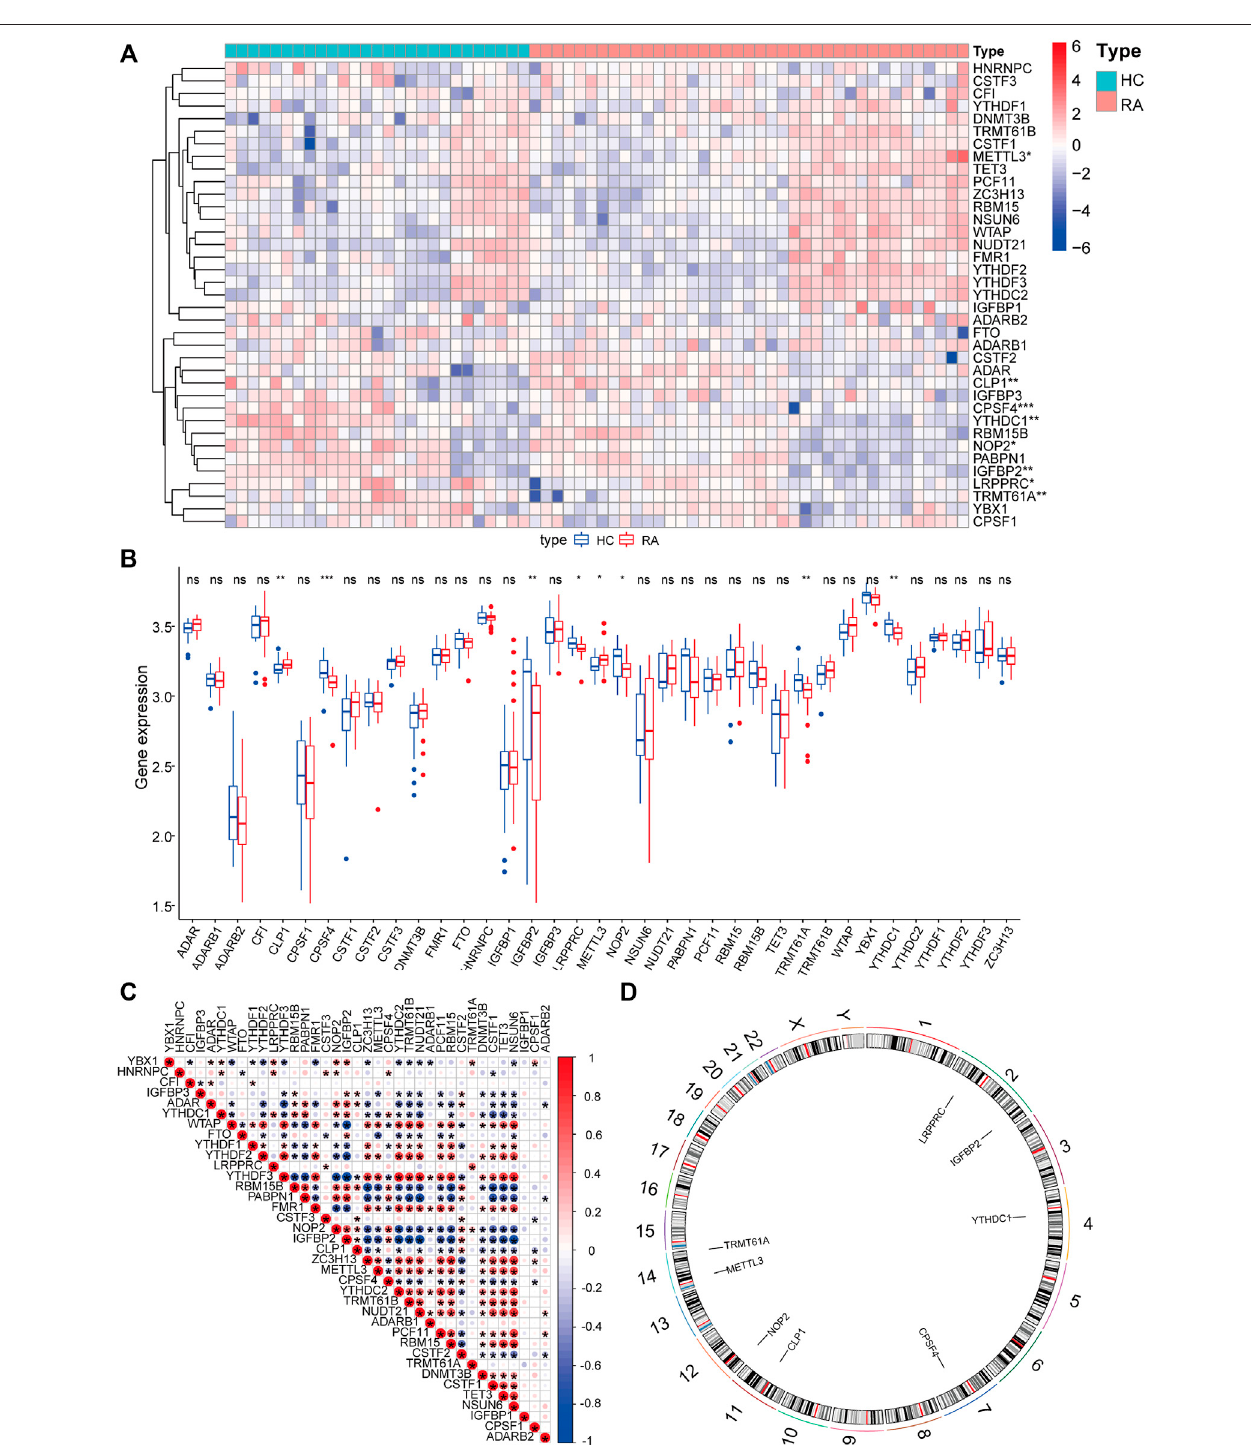
FIGURE 3 | Expression characteristics and gene location of RNA modi fi ers. (A) : Heat map shows the expression characteristics of RNA modi fi ers in rheumatoid synovial tissues and normal tissues. Red stands for high expression level, and blue for low expression level; (B) : box plot shows the difference in the expression of RNA modi fi ersinsynovialtissuesandnormaltissues,withsigni fi cantdifferencesintheexpressionof8genes. (C) :CorrelationanalysisofRNAmodi fi ers,positivecorrelationis represented by red while negative correlation isrepresented by blue. (D) : The position of adifferential gene on the chromosome (All fi gures * represents p < 0.05, ** represents p < 0.01, *** represents p < 0.001)